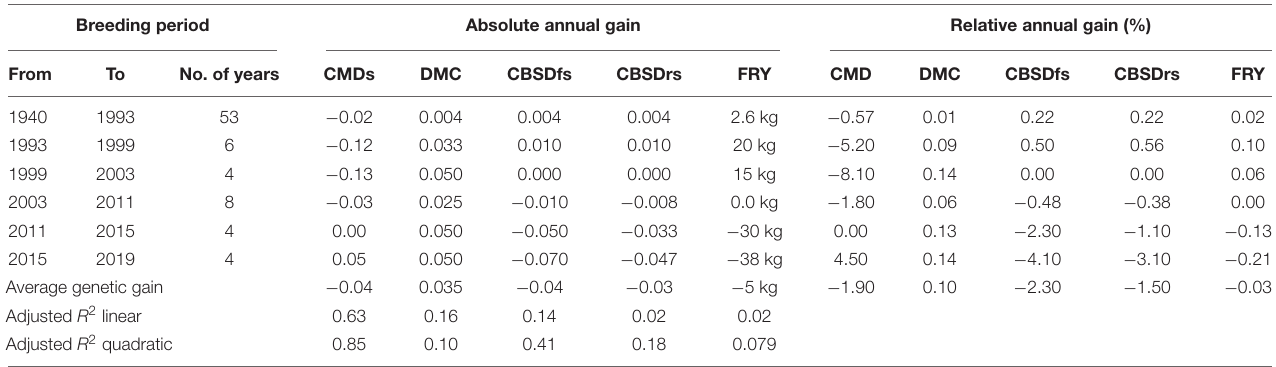
TABLE 6 | Genetic gains for cassava traits selected for between 1940 and 2019 in Uganda. Breeding